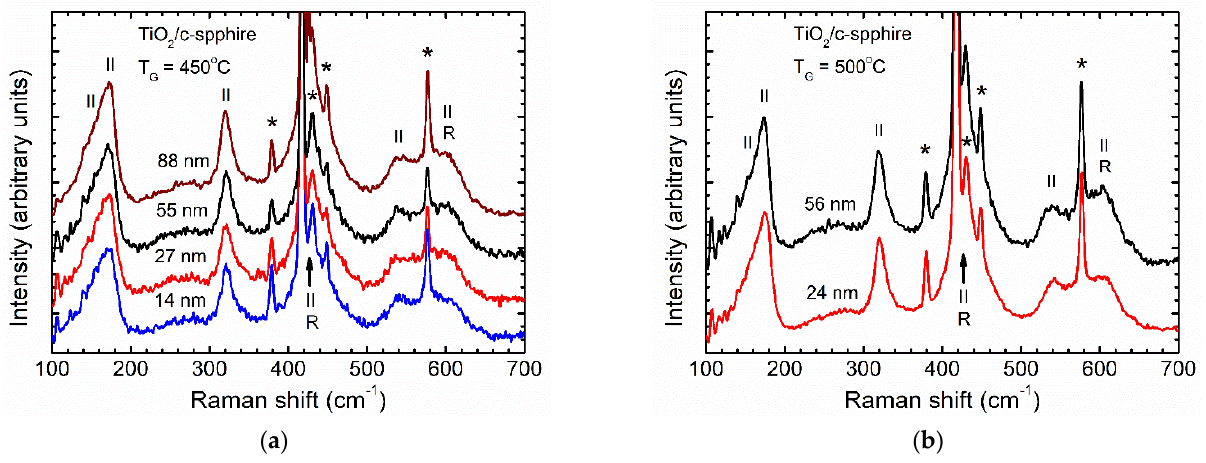
Figure 6. Raman spectra of TiO 2 films grown on c-sapphire at ( a ) 450 °C and ( b ) 500 °C to different thicknesses. Film thicknesses are shown at respective spectra. Raman bands attributed to rutile (R), TiO 2 -II (II) and substrates (*) are marked.